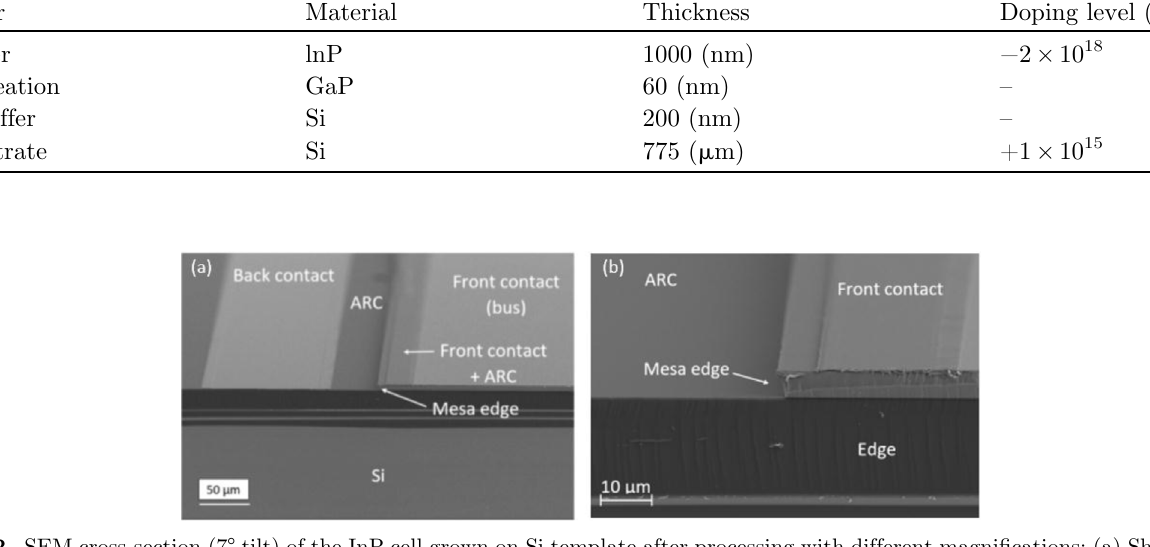
Fig. 2. SEM cross-section (7 ° tilt) of the InP cell grown on Si template after processing with different magni fi cations: (a) Shows an overview of top and back contacts together with the mesa edge; (b) zoom on the mesa edge and front